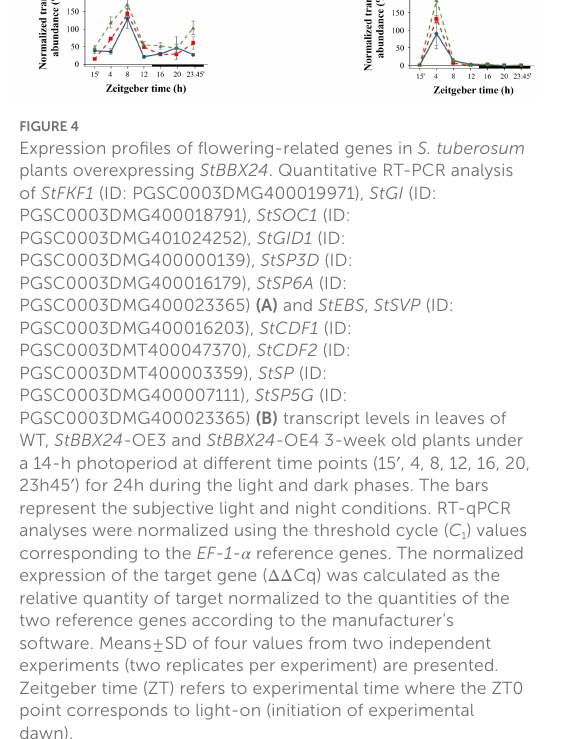
FIGURE 4 Expression profiles of flowering-related genes in S. tuberosum plants overexpressing StBBX24 . Quantitative RT-PCR analysis of StFKF1 (ID: PGSC0003DMG400019971), StGI (ID: PGSC0003DMG400018791), StSOC1 (ID: PGSC0003DMG401024252), StGID1 (ID: PGSC0003DMG400000139), StSP3D (ID: PGSC0003DMG400016179), StSP6A (ID: PGSC0003DMG400023365) (A) and StEBS , StSVP (ID: PGSC0003DMG400016203), StCDF1 (ID: PGSC0003DMT400047370), StCDF2 (ID: PGSC0003DMT400003359), StSP (ID: PGSC0003DMG400007111), StSP5G (ID: PGSC0003DMG400023365) (B) transcript levels in leaves